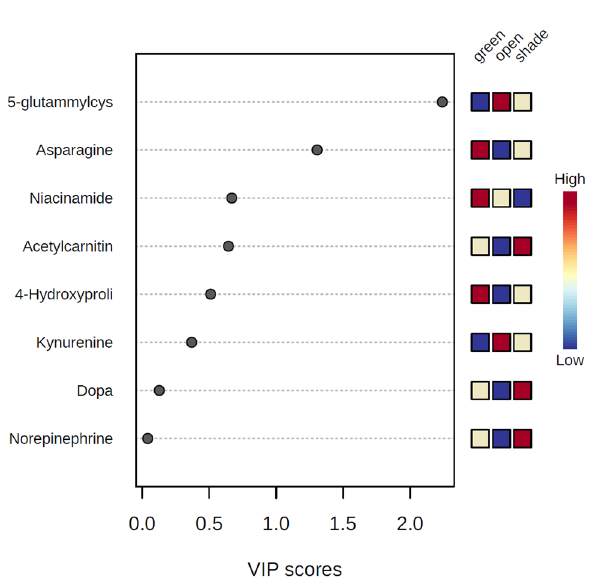
Figure 11. VIP scores of year one [2017/18] primary metabolites of African horned cucumber identified by PLS-DA. The coloured boxes on the right indicate the relative concentrations of the corresponding metabolite in each growing environment (greenhouse, shade net and open